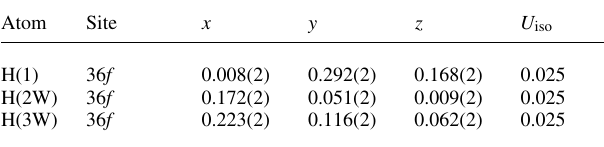
Table 2. Atomic coordinates and displacement parameters (in Å 2 )